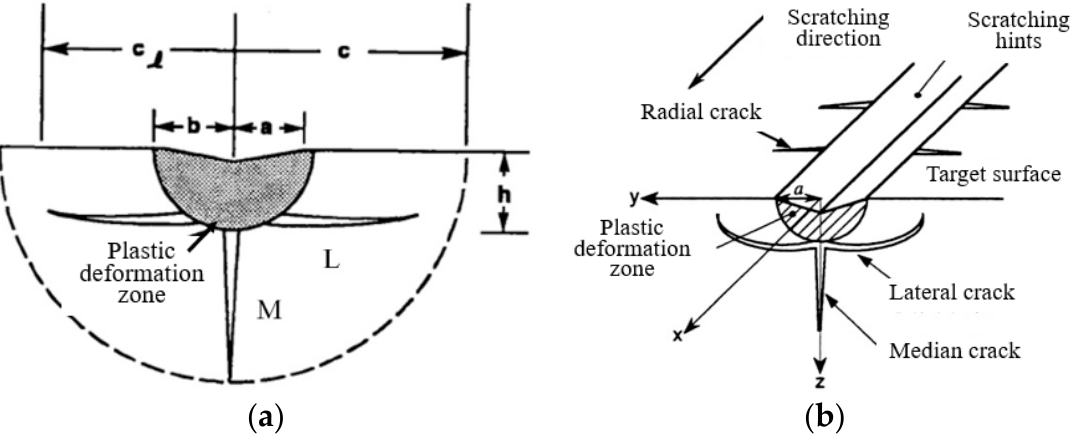
Figure 3. Grinding mechanism of hard brittle materials: ( a ) mechanical approximation of indentation process [7,8], ( b ) mechanical approximation of scratch process [13].